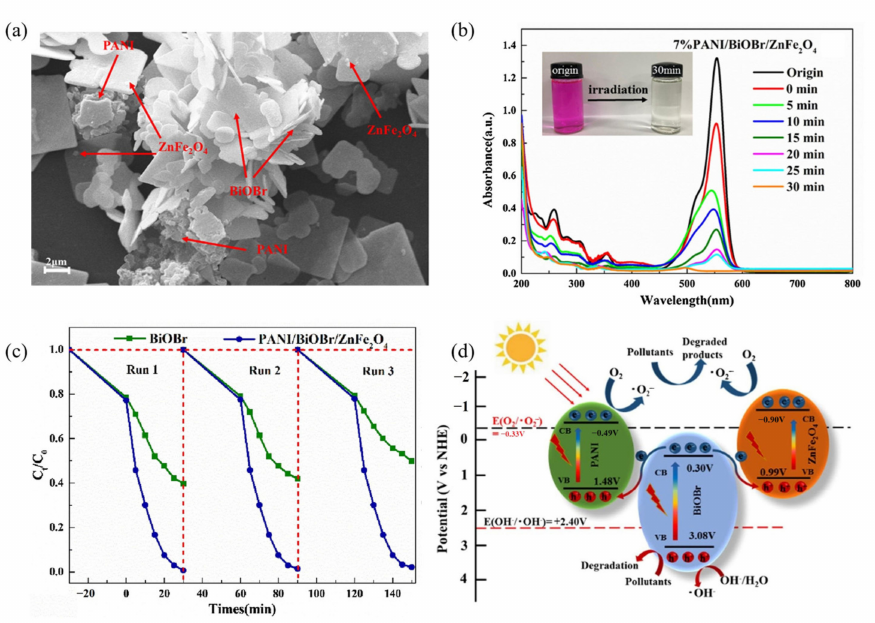
Figure 11. PANI/BiOBr/ZnFe 2 O 4 : ( a ) scanning electron microscopy (SEM) image; ( b ) the UV-Vis absorption spectra changes of RhB solution during the photocatalytic process over 7% PANI; ( c ) the cyclic photodegradation curves; ( d ) dual Z-scheme electron transfer and pollutant degradation mech- anism under visible-light exposure [102] (reprinted with permission from [102] Zhang et al., 2020).